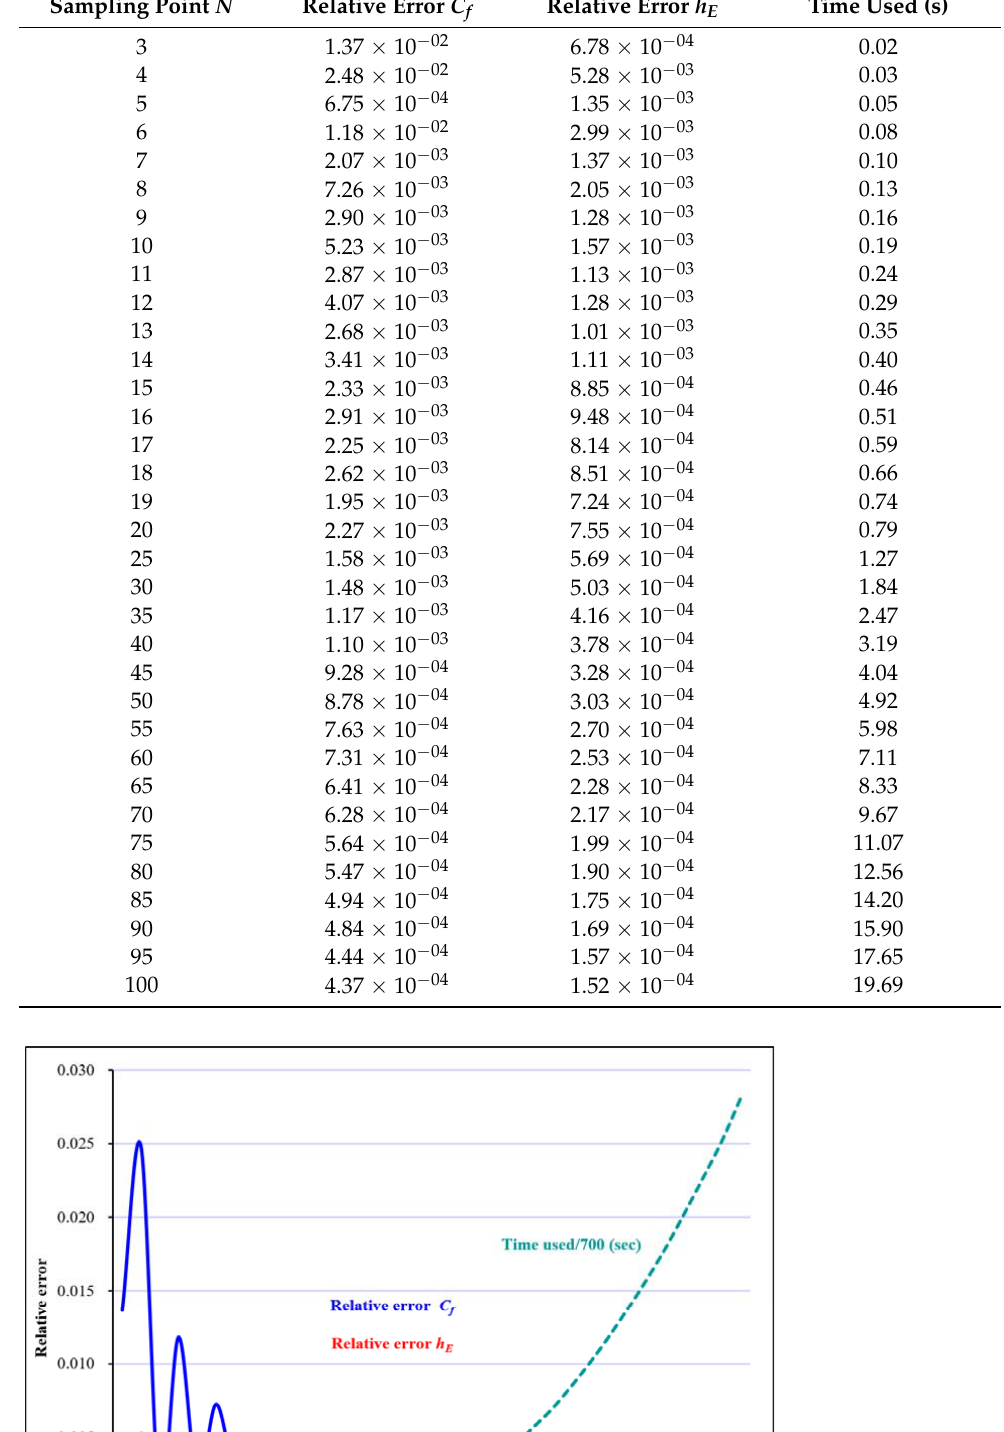
Table 6. Calculation results for an alternating distribution of positive and negative errors at the sampling points.